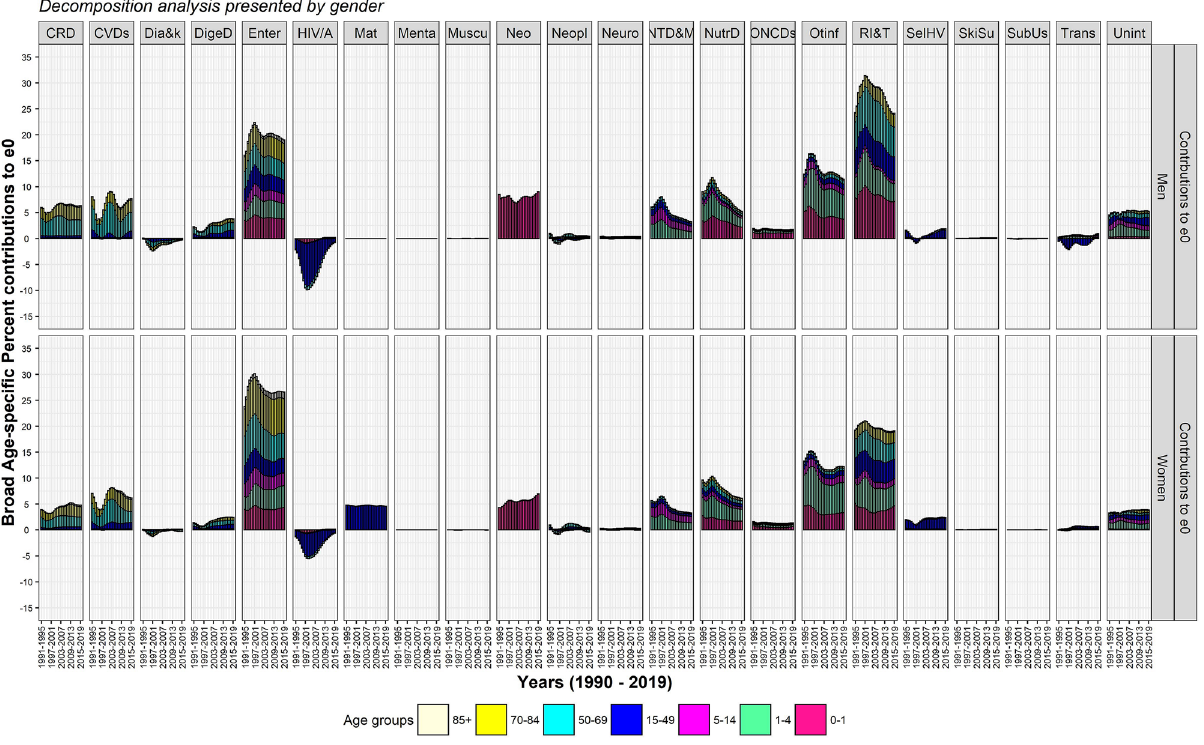
Figure 7. Temporal changes in age-cause-specific contributions to Δe 0 , men and women, India, 1990–2019. CRD , chronic respiratory diseases, CVDs cardiovascular diseases, Dia&k diabetes and kidney diseases, DigeD digestive diseases, Enter enteric (diarrhea and typhoid) infections, HIV/A HIV/AIDS and STI, Mat maternal disorders, Menta mental disorders, Muscu musculoskeletal disorders, Neo neonatal disorders, Neopl neoplasms, Neuro neurological disorders, NTD&M neg. tropical diseases and malaria, NutrD nutritional deficiencies, ONCDs other noncommunicable diseases, Otinf other infectious diseases, RI&T respiratory infections